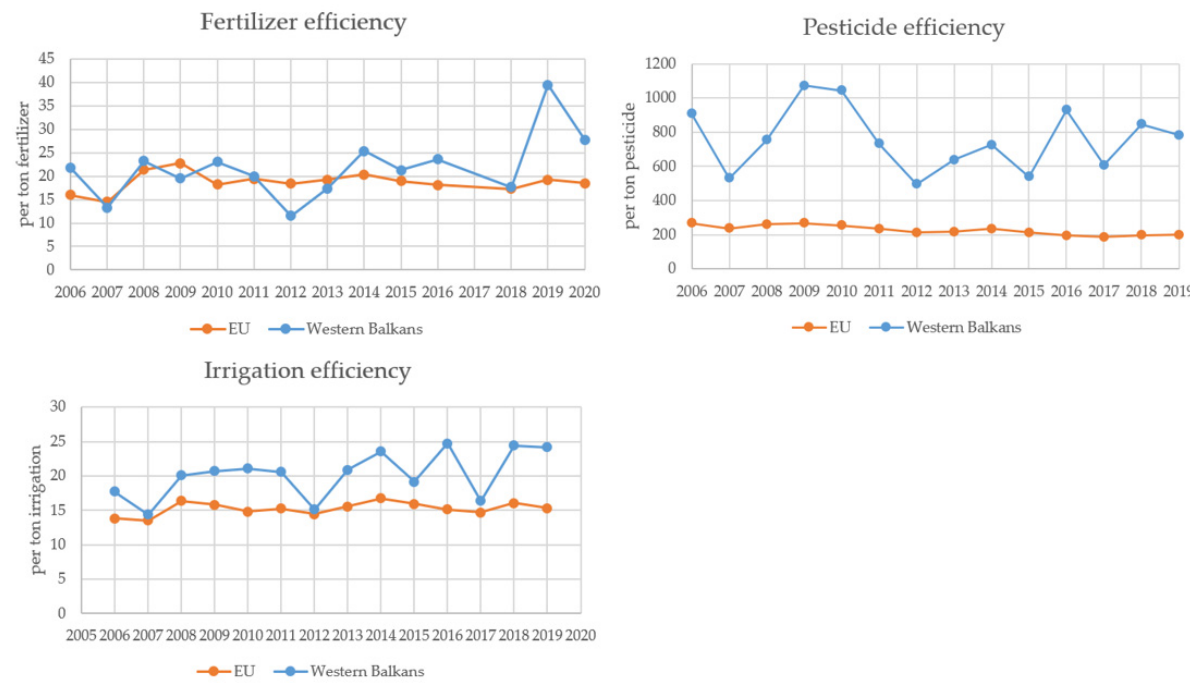
Figure 6. Inputs efficiency in the Western Balkans and the EU. Source. The authors’ calculation.